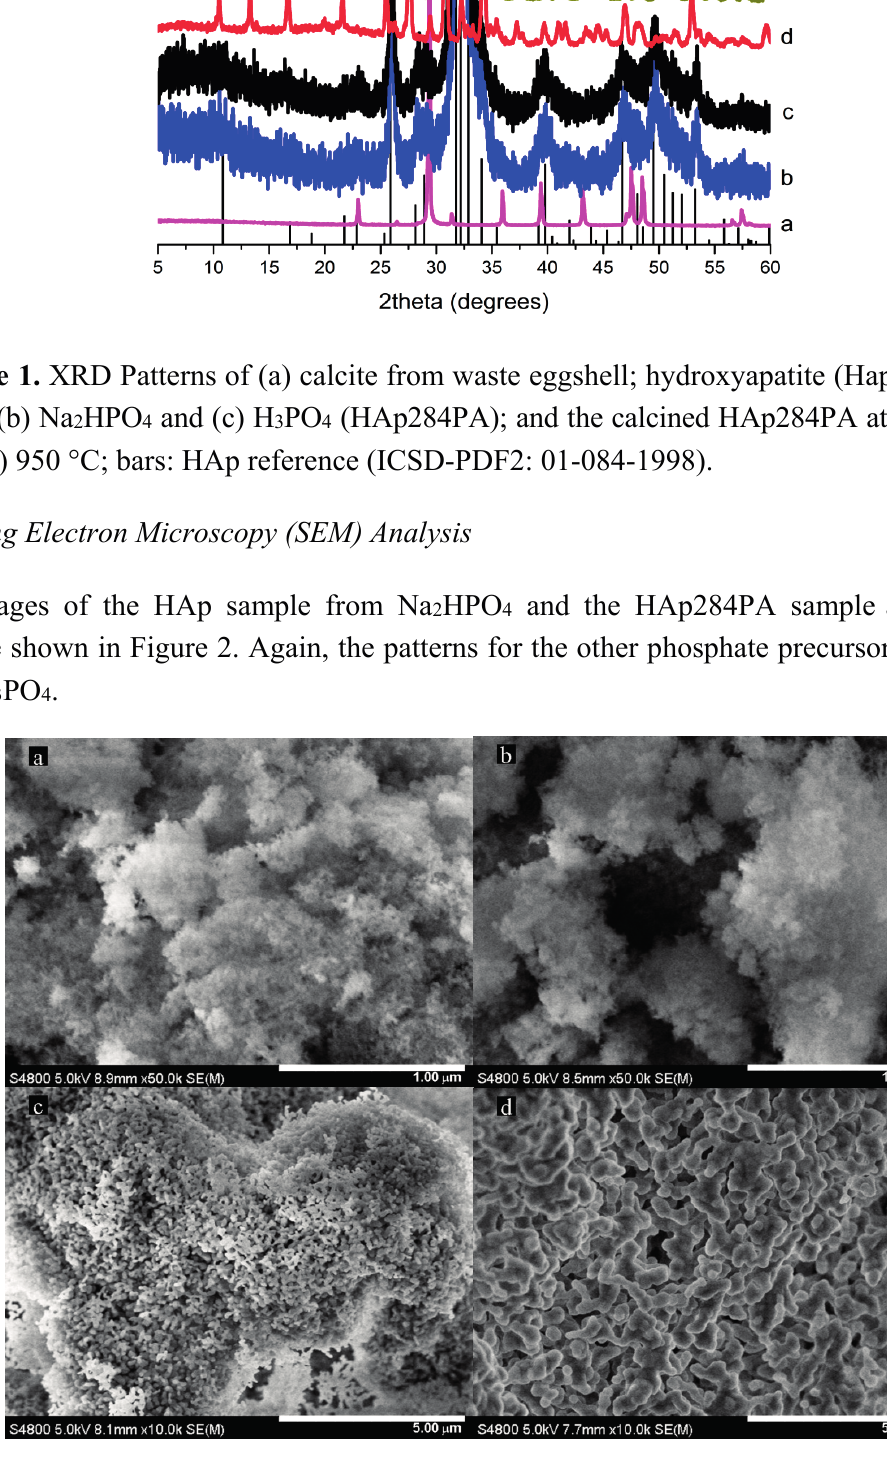
Figure 2. SEM images of HAp produced using ( a ) Na 2 HPO 4 and ( b ) H 3 PO 4 (HAp284PA); and the calcined HAp284PA at ( c ) 700 °C and ( d ) 950